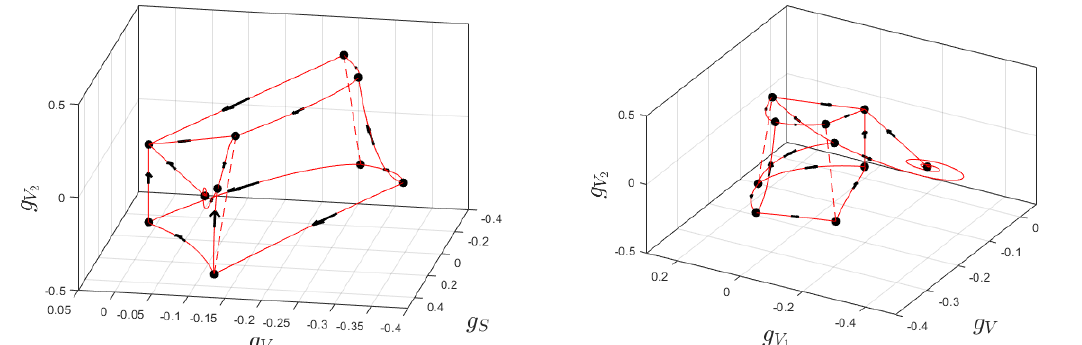
Figure 9. Fixed points and critical heteroclinic orbits in the QCD (3 ; 15) and (cid:11) g = 0. Solid line: heteroclinic connections. Dashed lines: heteroclinic connections that are expected to exist, but have not been found numerically. Left: projection on the ( g S ; g V ; g V space. Right: projection on the ( g V ; g V